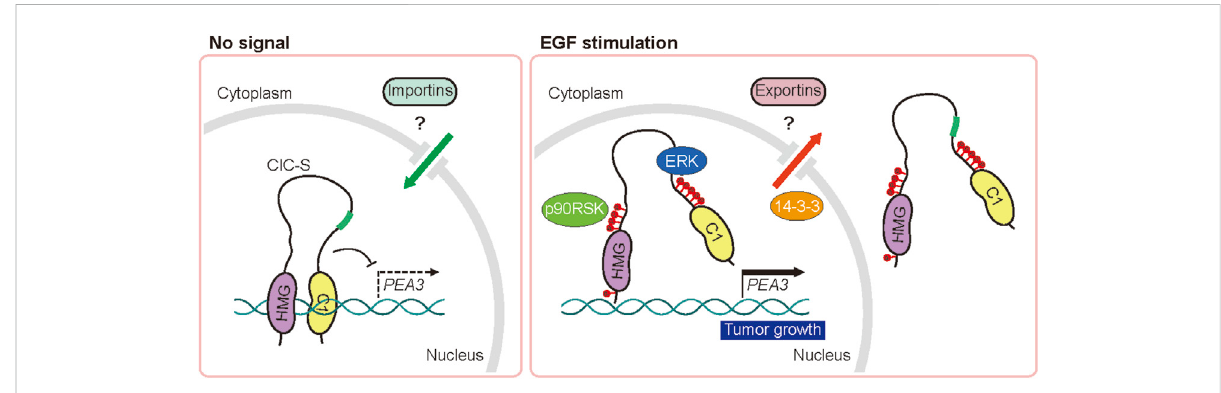
FIGURE 5 Schematic model of the regulation of nucleocytoplasmic transport of CIC by the EGFR signaling pathway. EGFR stimulation-activated ERK and p90RSK disrupt the intramolecular interaction of CIC via phosphorylation of serine and threonine residues (red circles), leading to dissociation from DNA and cytoplasmic translocation of